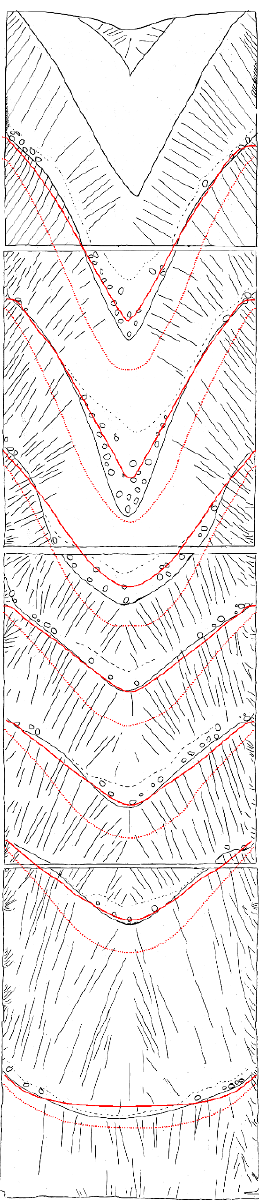
Figure 2. Experimental (black) and simulated pool profiles (red), reproduced from reference [23].